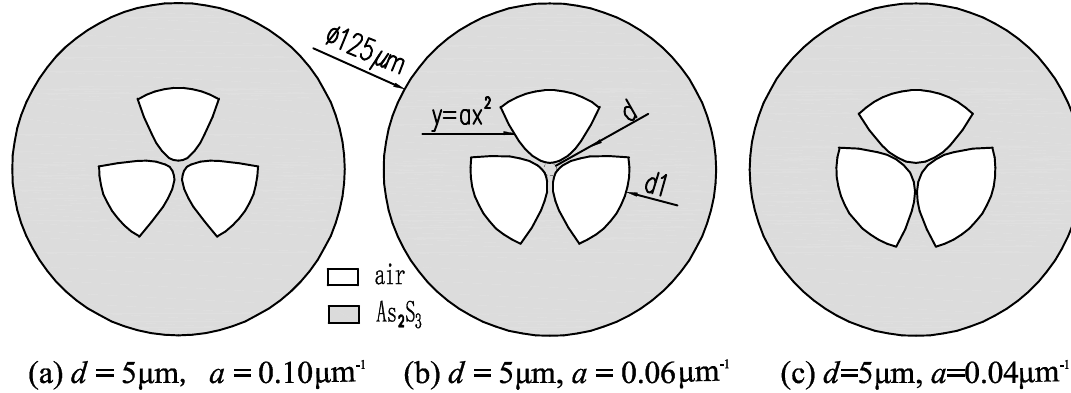
Figure 2. Design views of the SCF geometrical formation.